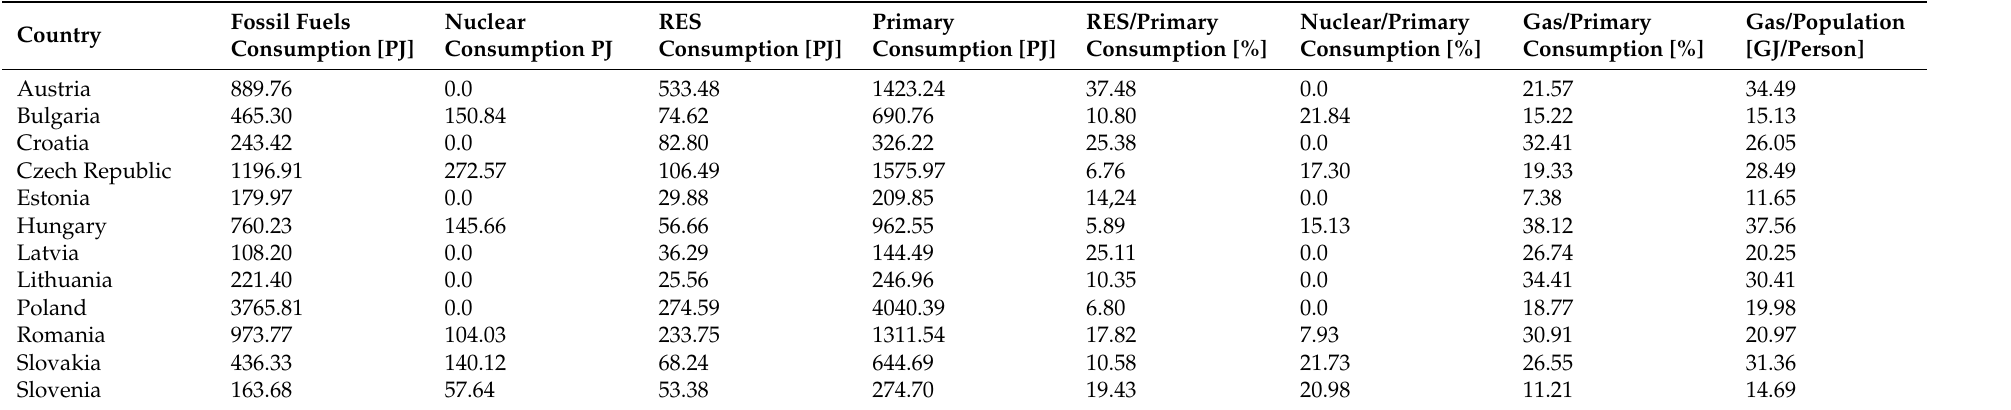
Table 1. Consumption of energy carriers in 2020 calculated with the help of the BP database